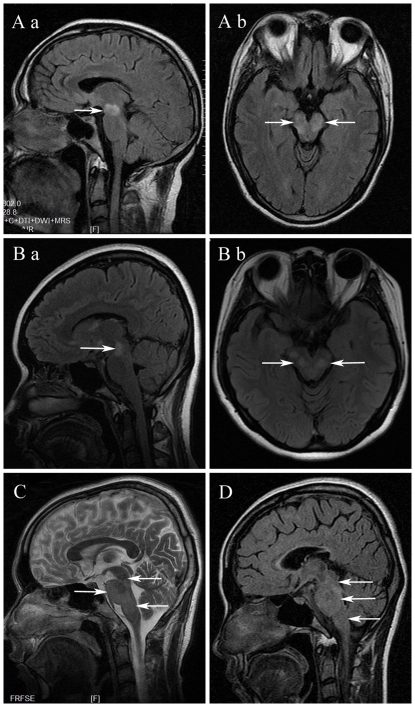
Brain stem lesions (arrows) on MRI of acute disseminated encephalomyelitis (ADEM).(A, B) Fluid-attenuated inversion recovery (FLAIR) image showing midbrain lesions with poorly defined margins located in the ventral part (symmetrical or bilateral). (C, D) Sagittal image highlighting multiple brain stem lesions (midbrain, pons, medulla) with poorly defined margins.